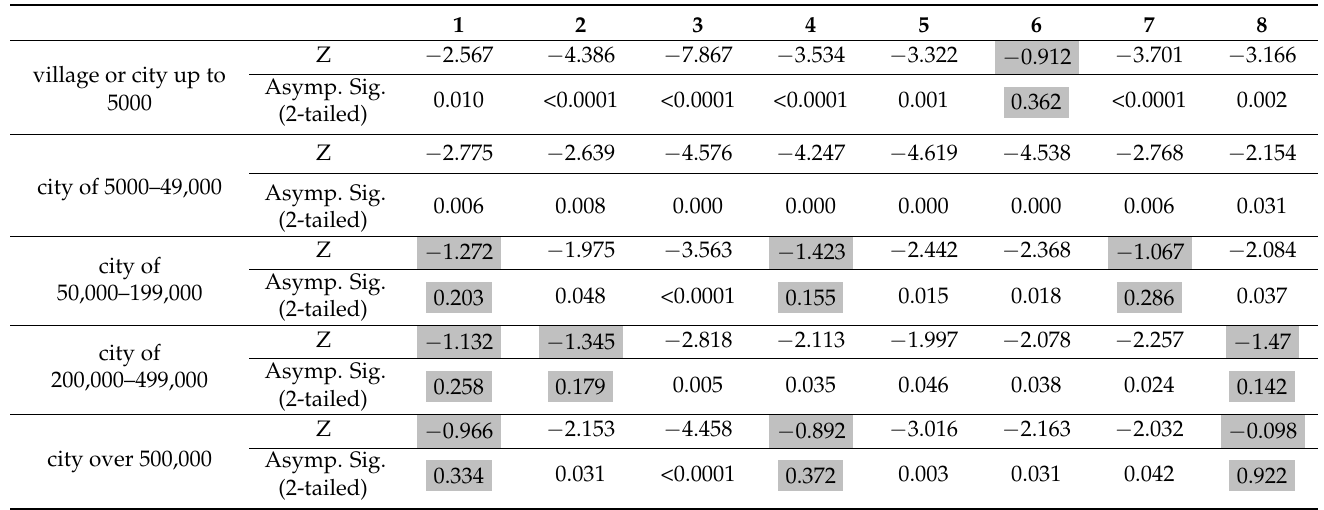
Table 10. Place of residence-based consumer